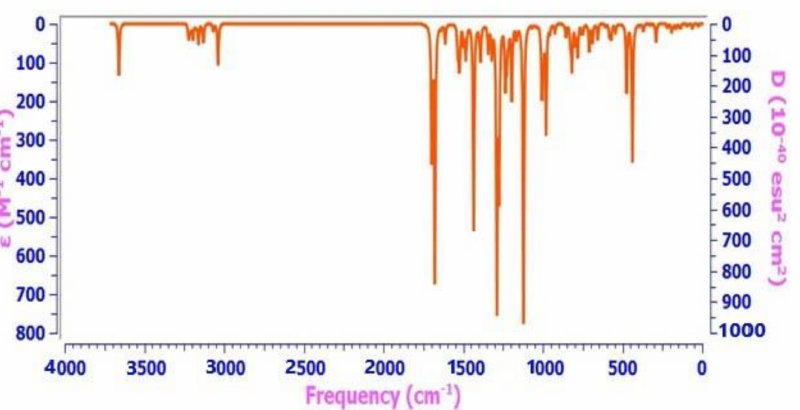
Figure 1. FT-IR theoretical spectrum of methyl 2-((2-nitrophenyl)(hydroxyl)methyl) acrylate